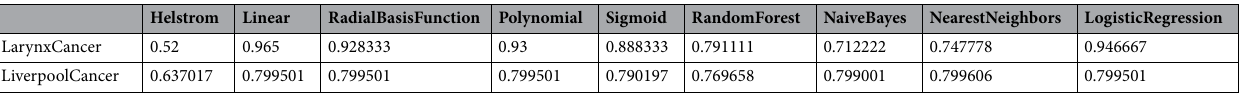
Table 8. Death/alive laryngeal cancer patients and case-control marks of cancer cases in North Liverpool.